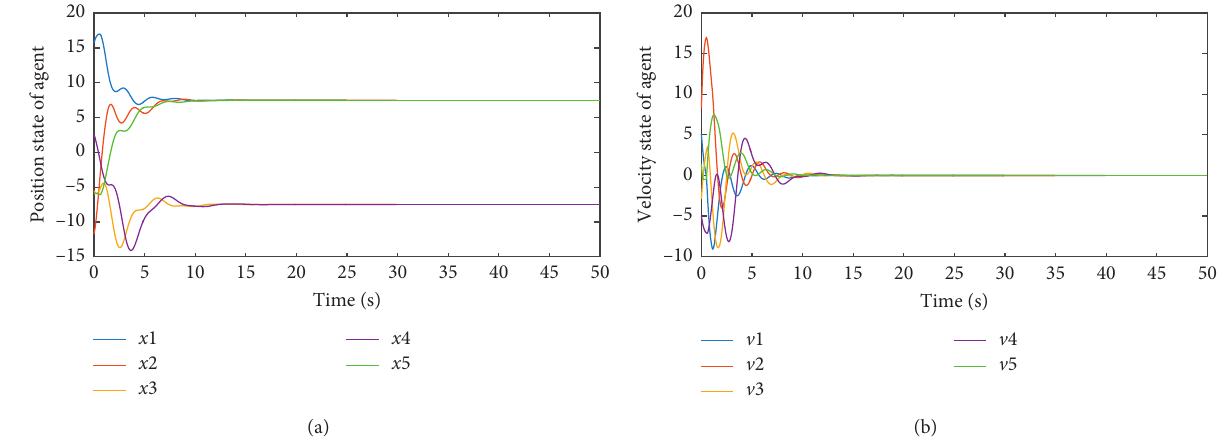
Figure 3: Position and velocity states of agents on the structurally balanced network in Figure 1(a).